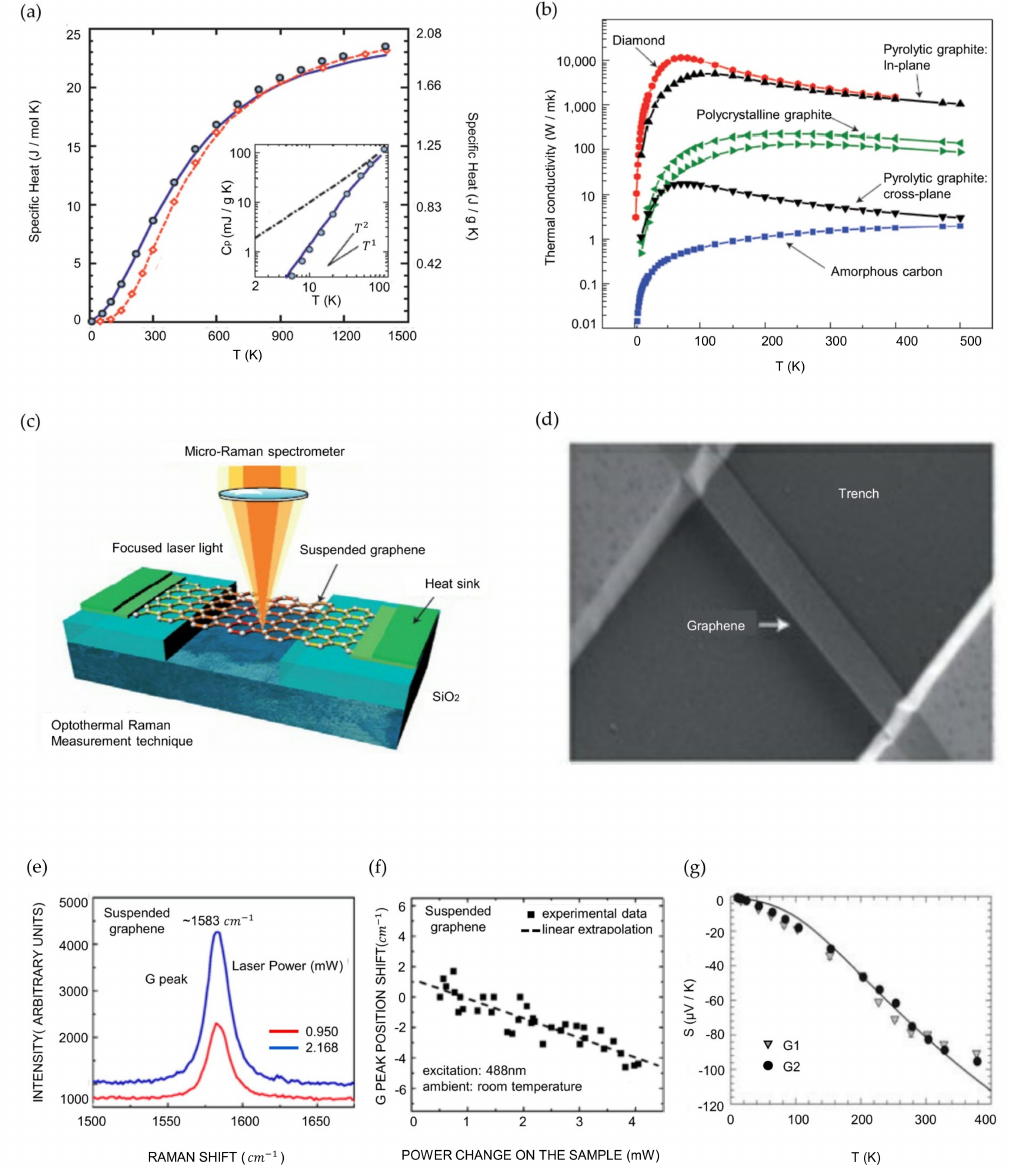
Figure 3. Thermal properties of graphene ( a ) Specific heats of graphite, diamond, and graphene. The inset compares the specific heats of graphene and graphite at low temperature; ( b ) Thermal conductivity of bulk carbon allotropes as a function of temperature; ( c ) Figure of a graphene layer suspended across a trench and the measurement of the thermal conductivity; ( d ) SEM image of a suspended graphene layer across a 3- µ m-wide trench in a Si wafer; ( e ) Raman spectrum of graphene showing the G-peak region measured at two different power levels; ( f ) Graph showing the G-peak position shift versus power change; ( g ) Graph of measured Seebeck coefficients as a function of temperature for graphene samples. (a) Reproduced with permission from [171]. Copyright MRS Bulletin, 2012. (b), (c), (d) Reproduced with permission from [16]. Copyright Nature Materials, 2011. (e), (f) [176]. Copyright Nano Letters, 2008. (g) Reproduced with permission from [18]. Copyright Science,